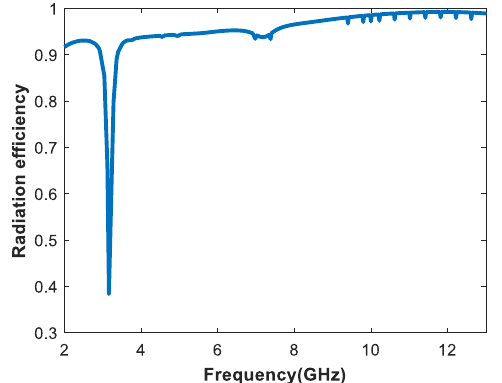
Figure 10. Simulated radiation efficiency of the proposed antenna.